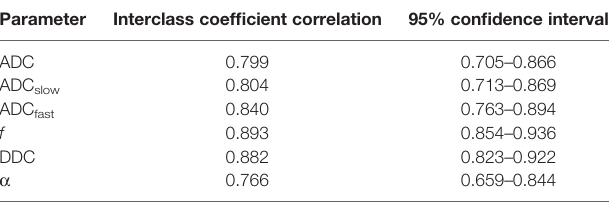
TABLE 1 | Interobserver reproducibility in the assessment of different DWI